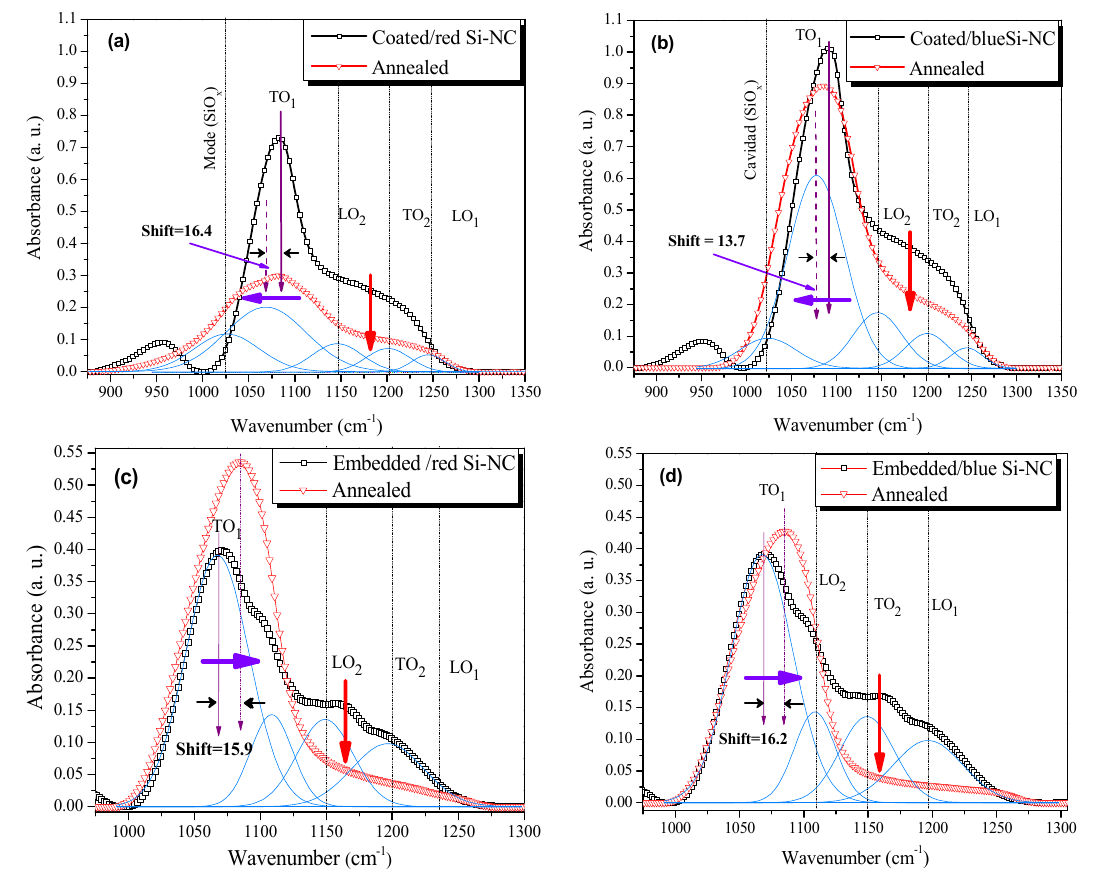
Figure 6. (Color Online) FTIR spectra of coated and embedded films before and after annealing at 1100 °C for 3 h in N 2 atmosphere. ( a , b ) are the IR (infrared) spectra of coated films with red and blue Si ‐ NCs, respectively; ( c , d ) are the IR spectra of embedded films with red and blue Si ‐ NCs, respectively.